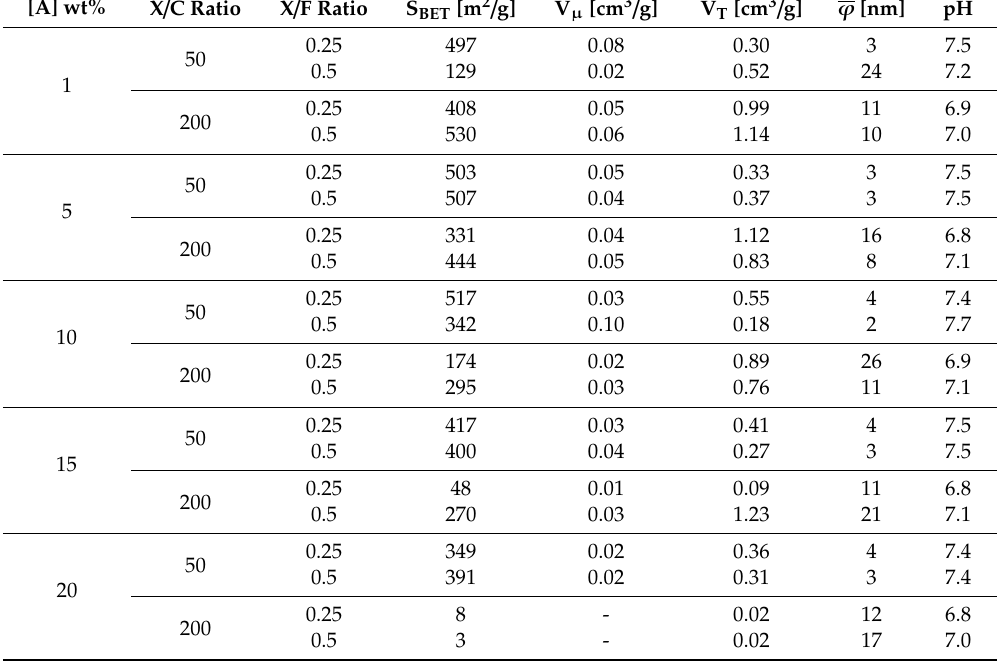
Table A2. Textural properties and initial reaction mixture pH values for gels with ammeline as the additive.